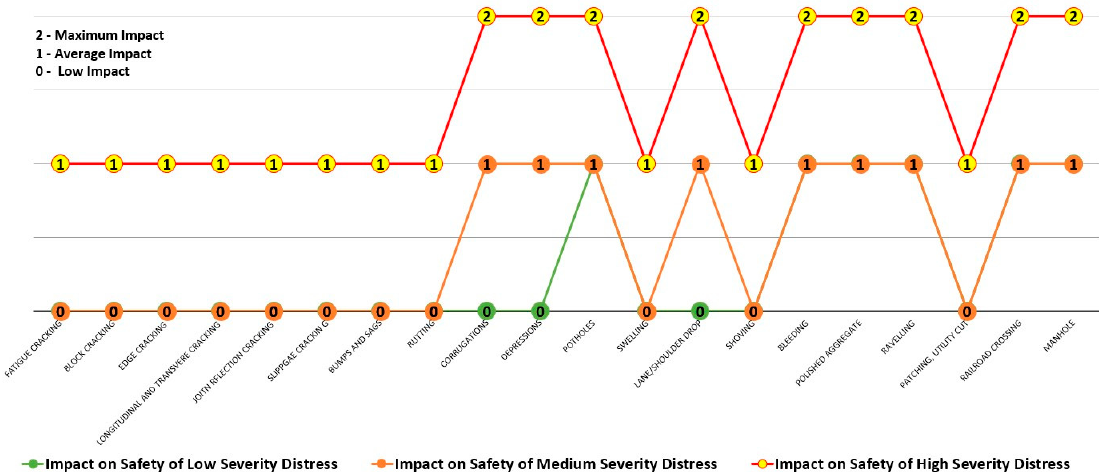
Figure 6. Impacts of the severity of pavement distresses on safety.